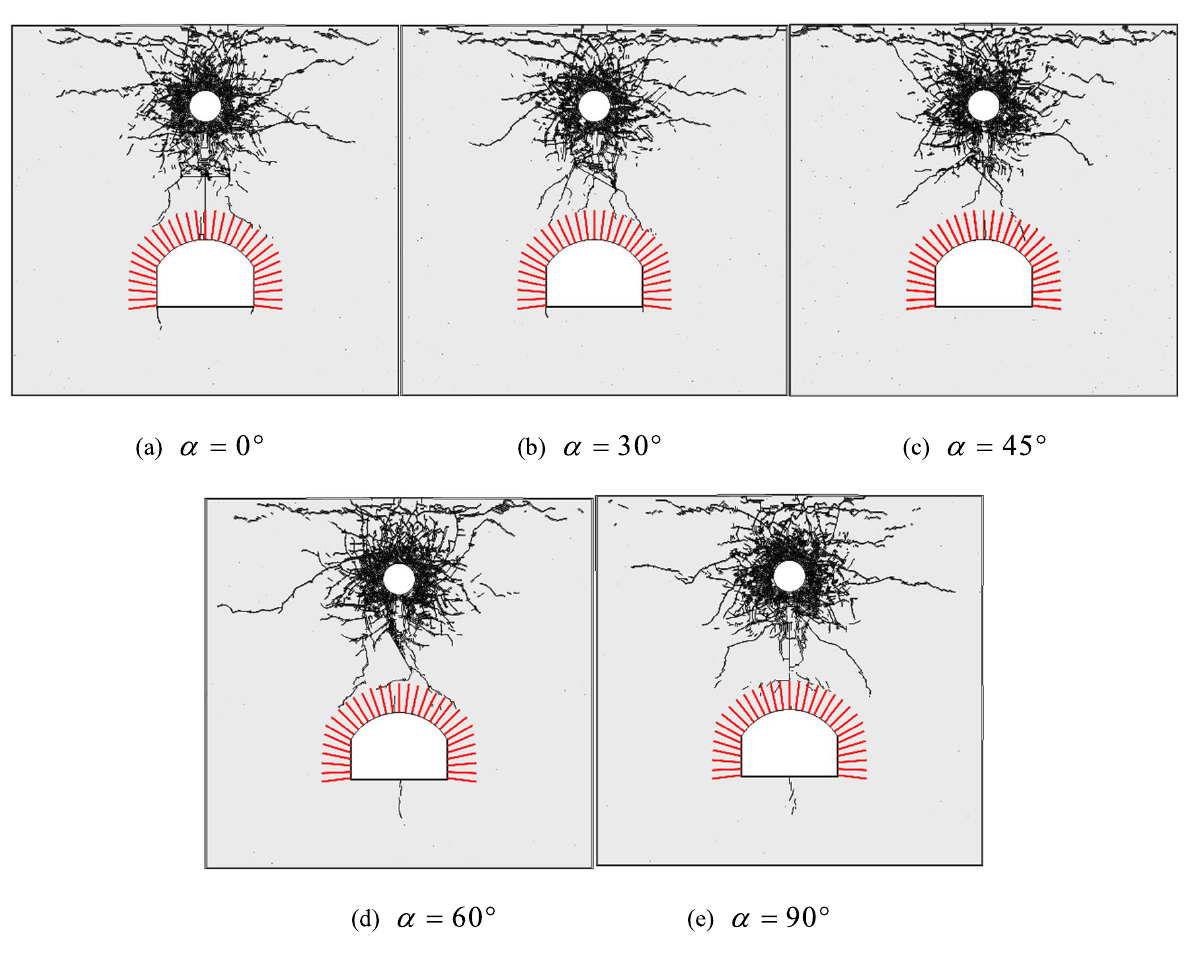
Figure 13. The crack distribution around an anchored cavity with cracks at different dip